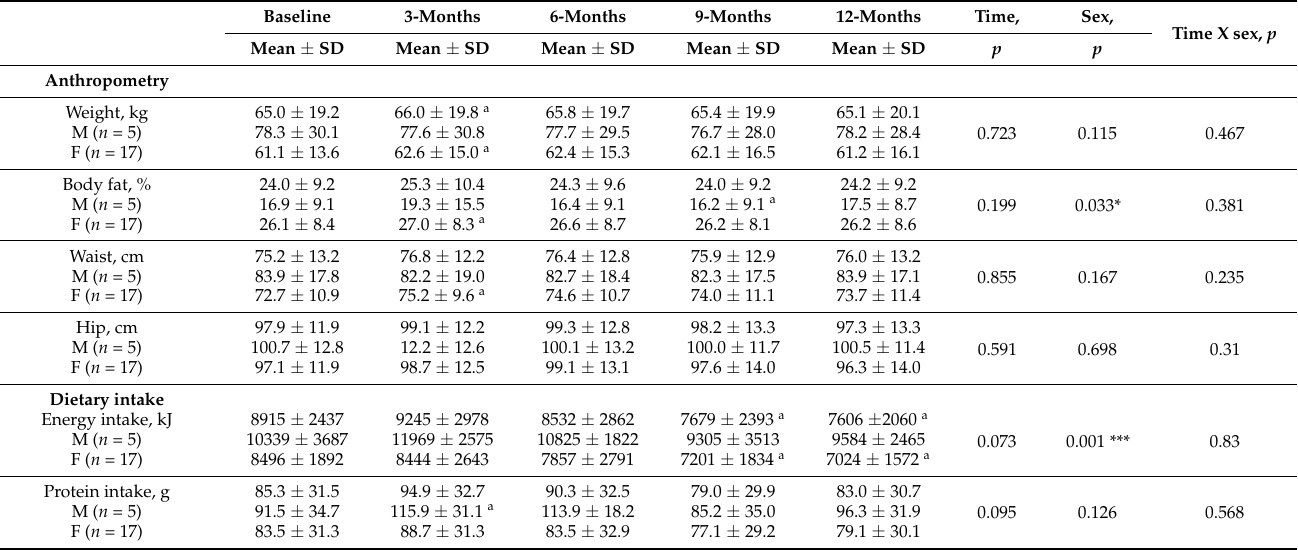
Table 2. Anthropometric, physical activity, dietary intake, and eating behaviour in 22 students during their first year at an Australian